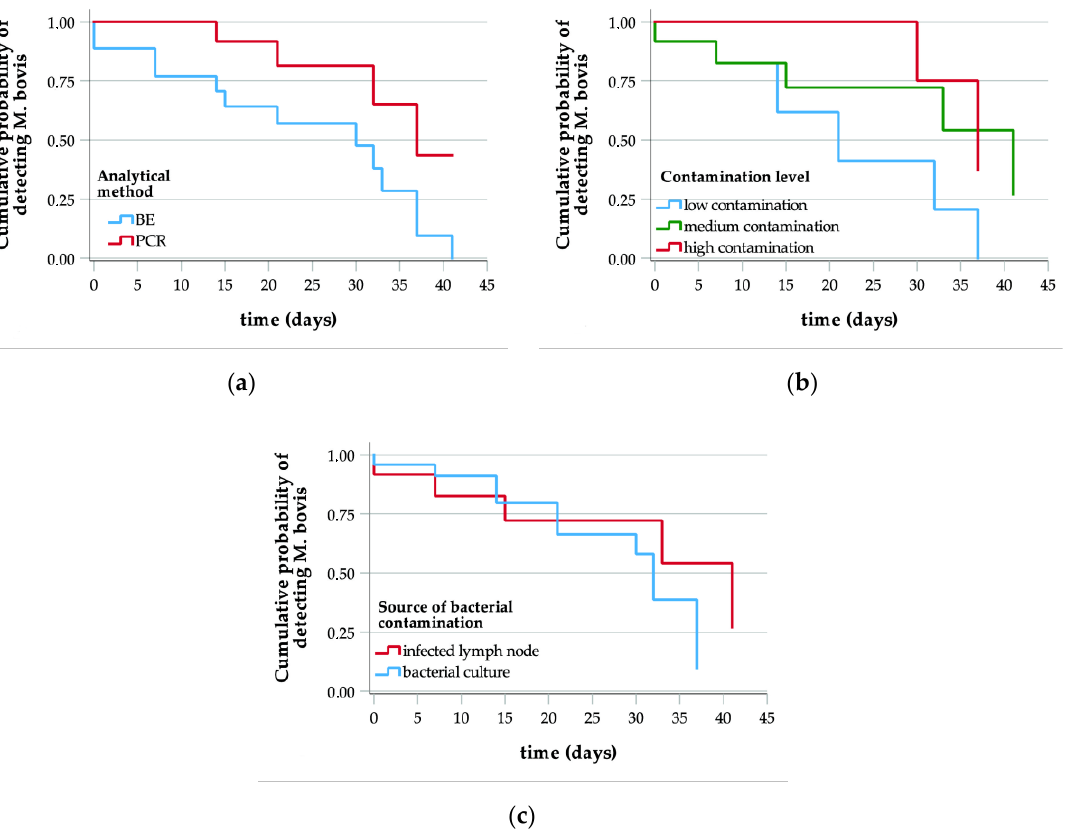
Figure 1. Curves following from the Kaplan-Meier method concerning the whole data set from first, second, third experimental batches. The panels present the data compared for ( a ) the analytical method, ( b ) the contamination level of the matrix, and ( c ) the contamination source/procedure.